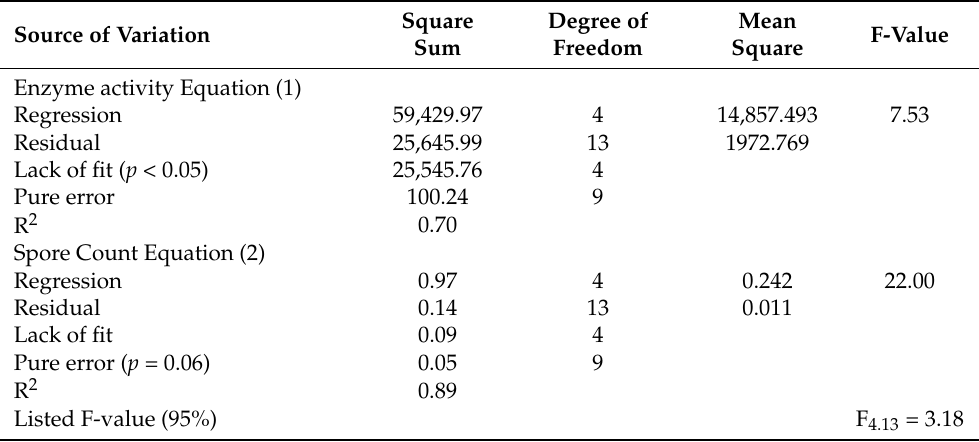
Table 4. Analysis of variance (ANOVA) to validate the models (Equations (1) and (2)). Source of